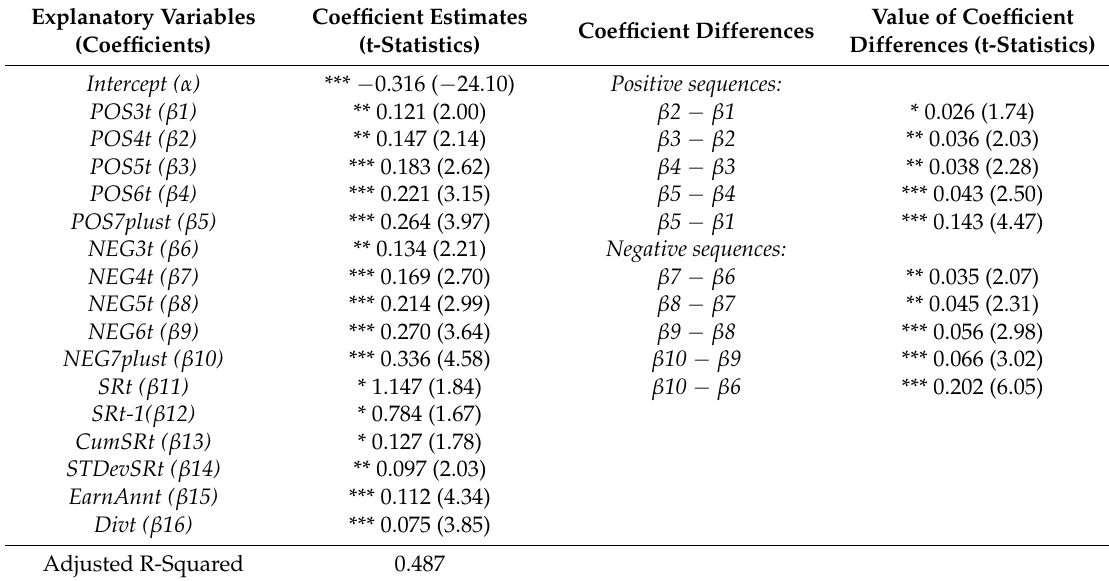
Table 4. Multifactor regression analysis (regression (4)): Return sequence effect on stock trading volumes (Dependent variable—ABVOL).